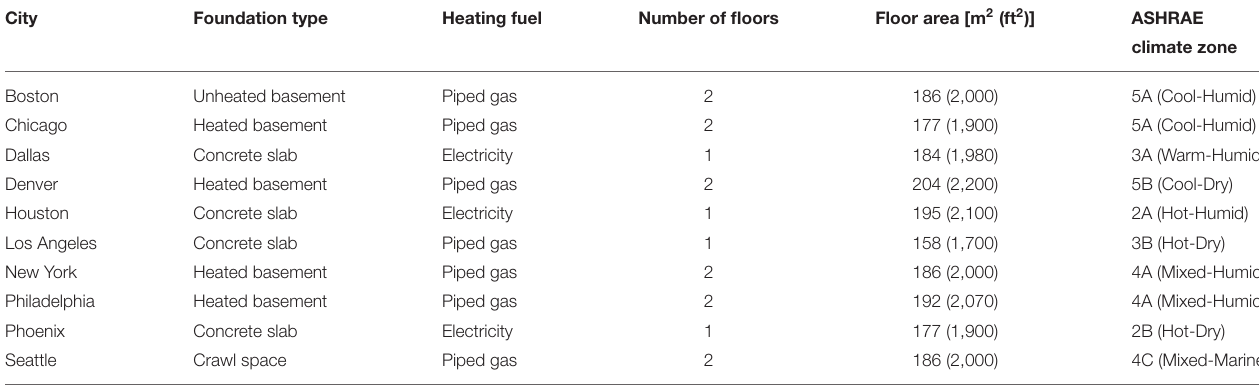
TABLE 1 | Characteristics of typical single family residential buildings in each city.